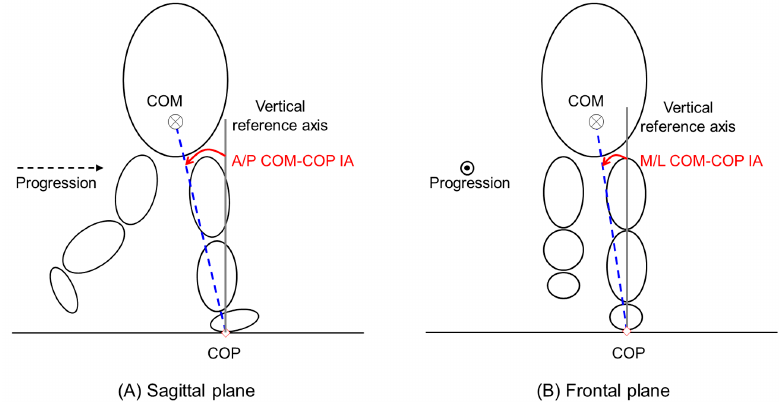
Figure 2. Configuration of the center of mass–center of pressure (COM-COP) inclination angle (IA) in the sagittal plane ( A ) and frontal plane ( B ).